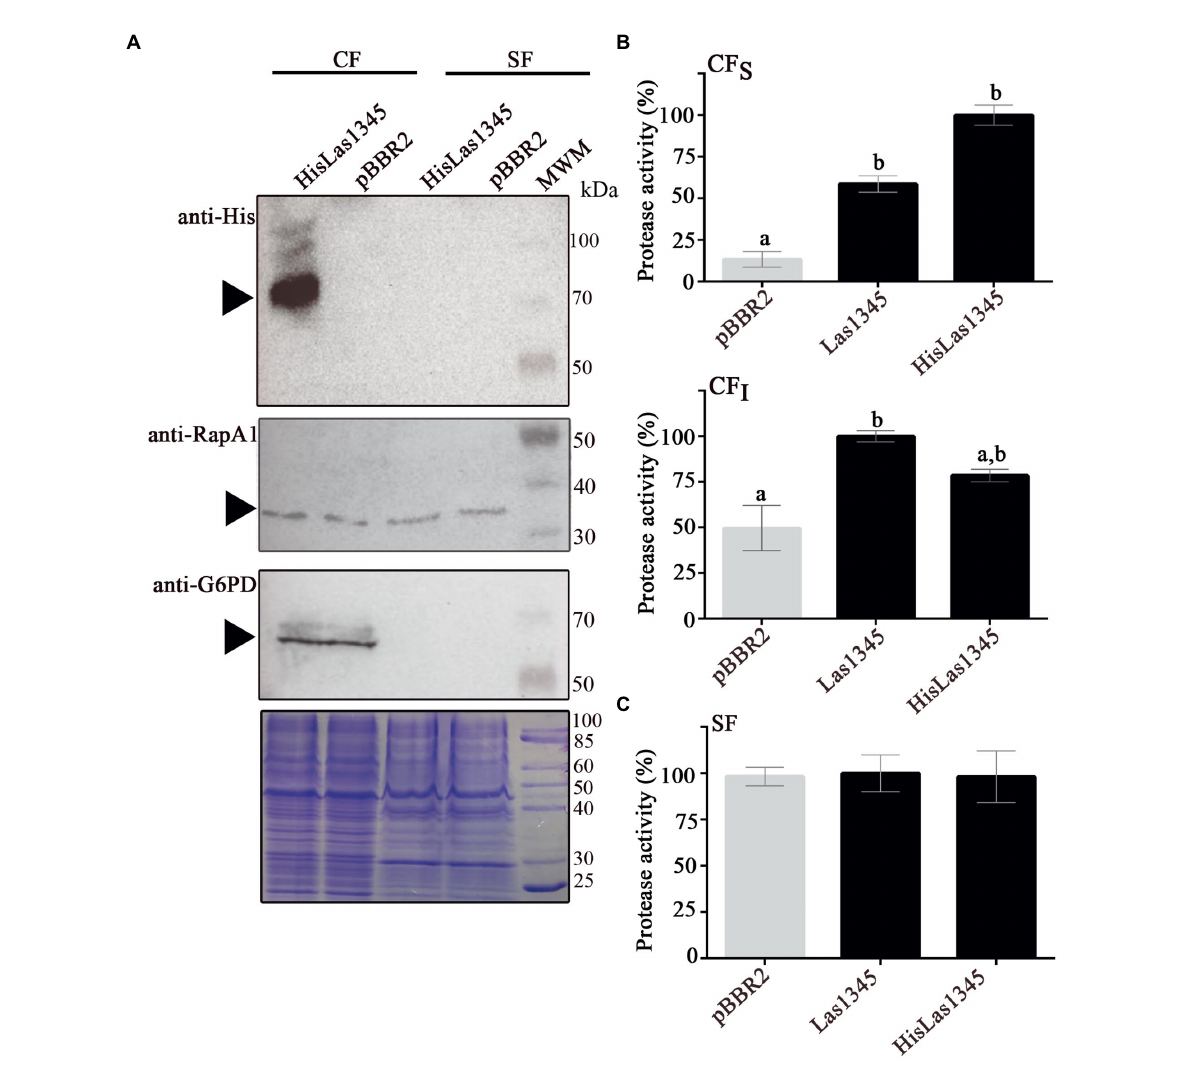
FIGURE 2 Las1345 has intracellular protease activity in Rhizobium leguminosarum . (A) Immunodetection of Las1345 (~75 kDa) in cellular (CF) and supernatant cell free fraction (SF) from Rhizobium leguminosarum A34 ( A34 ) cells expressing Las1345, HisLas1345 or transformed with the empty vector (pBBR2), grown for 16 h at 30 ° C. Rhizobium adhering protein A1 (RapA1, ~36 kDa) and Glucose-6-phosphate dehydrogenase (G6PD, ~55 kDa) were used as extracellular and intracellular controls, respectively. (B) Protease activity in SF from A34 cultures (C) , Protease activity in soluble and insoluble CF (CF S and CF I ) from A34 cultures. The relative activity was expressed as the percentage of activity detected with respect to the maximum protease activity in the assay. Values are expressed as means ± standard deviations from six independent biological replicates. Different letters indicate significant differences at p < 0.05 (one-way analysis of variance, Tukey’s